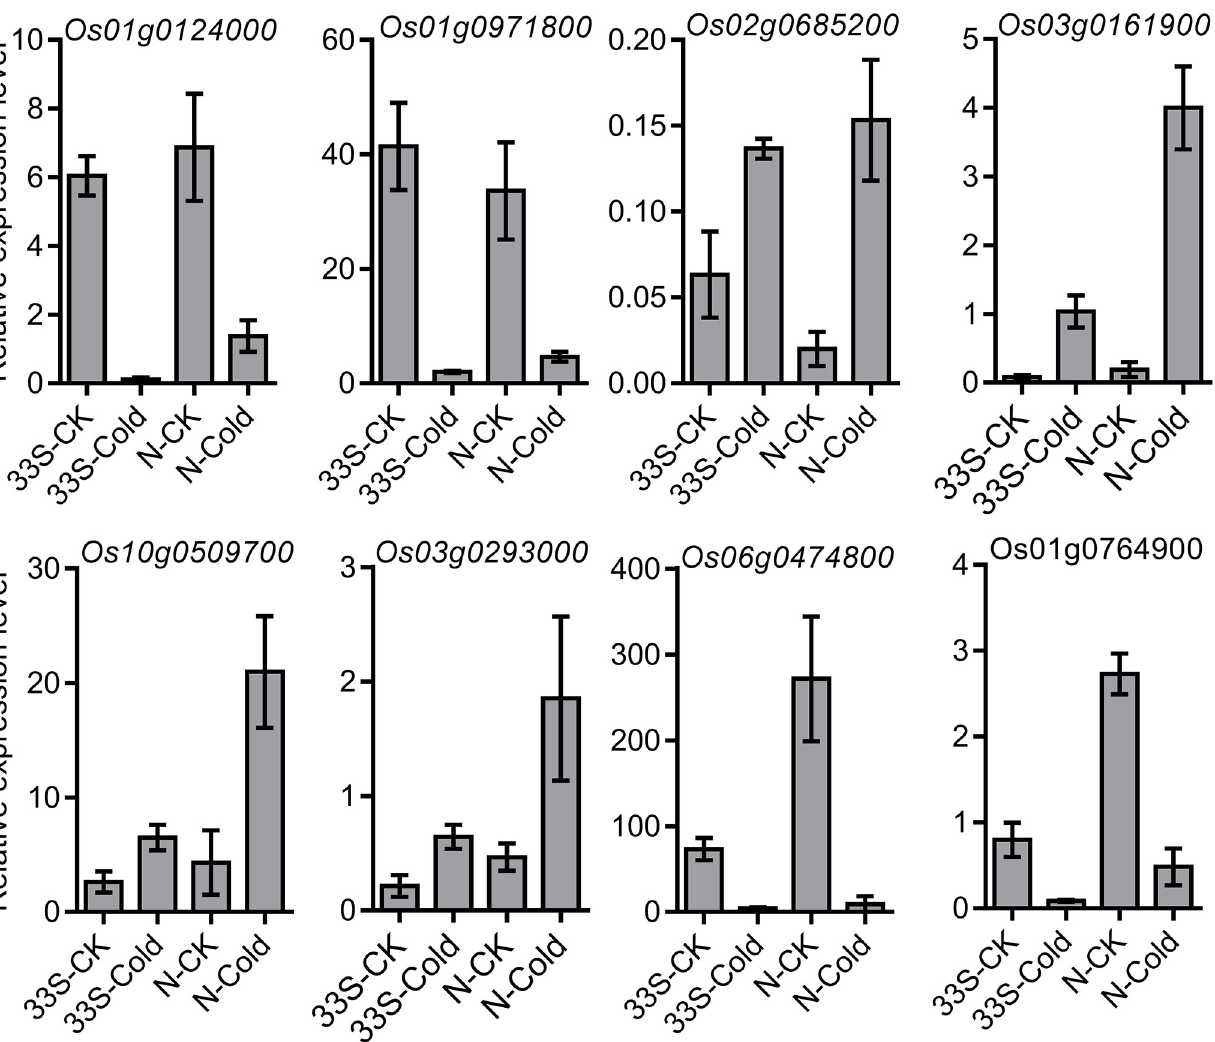
Fig 4. RT-qPCR verification of expression profiles obtained through RNA-seq. Data are mean ± SD of three biological replicates. Asterisks indicate significant difference compared to control samples ( � P < 0.05; �� P < 0.01). The actin 1 gene was used as an internal standard gene was used as an internal